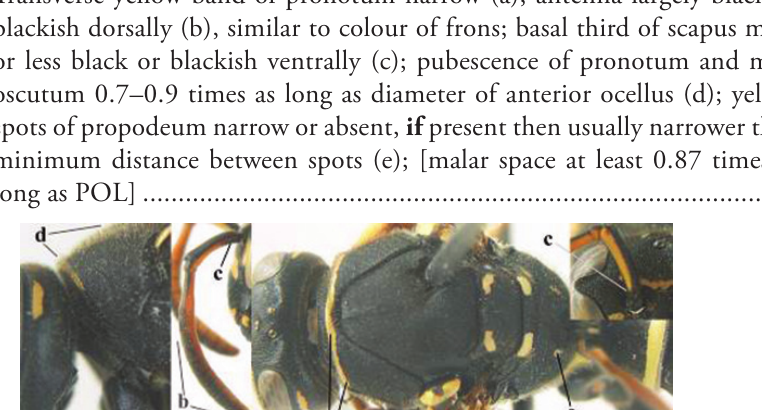
- Transverse yellow band of pronotum wider (aa); antenna orange brown or somewhat darkened dorsally (bb) and distinctly paler than frons; basal third of scapus yellow ventrally (cc), but darkened in most P. foederatus ; pubescence of pronotum and mesoscutum about half as long as diameter of anterior ocel- lus (dd), but longer in P. bischoffi (ddd); yellow spots of propodeum wide and usually larger (ee), but sometimes smaller in P. foederatus ; [malar space usually shorter than 0.87 times POL, except in P. foederatus ] ................................ 18